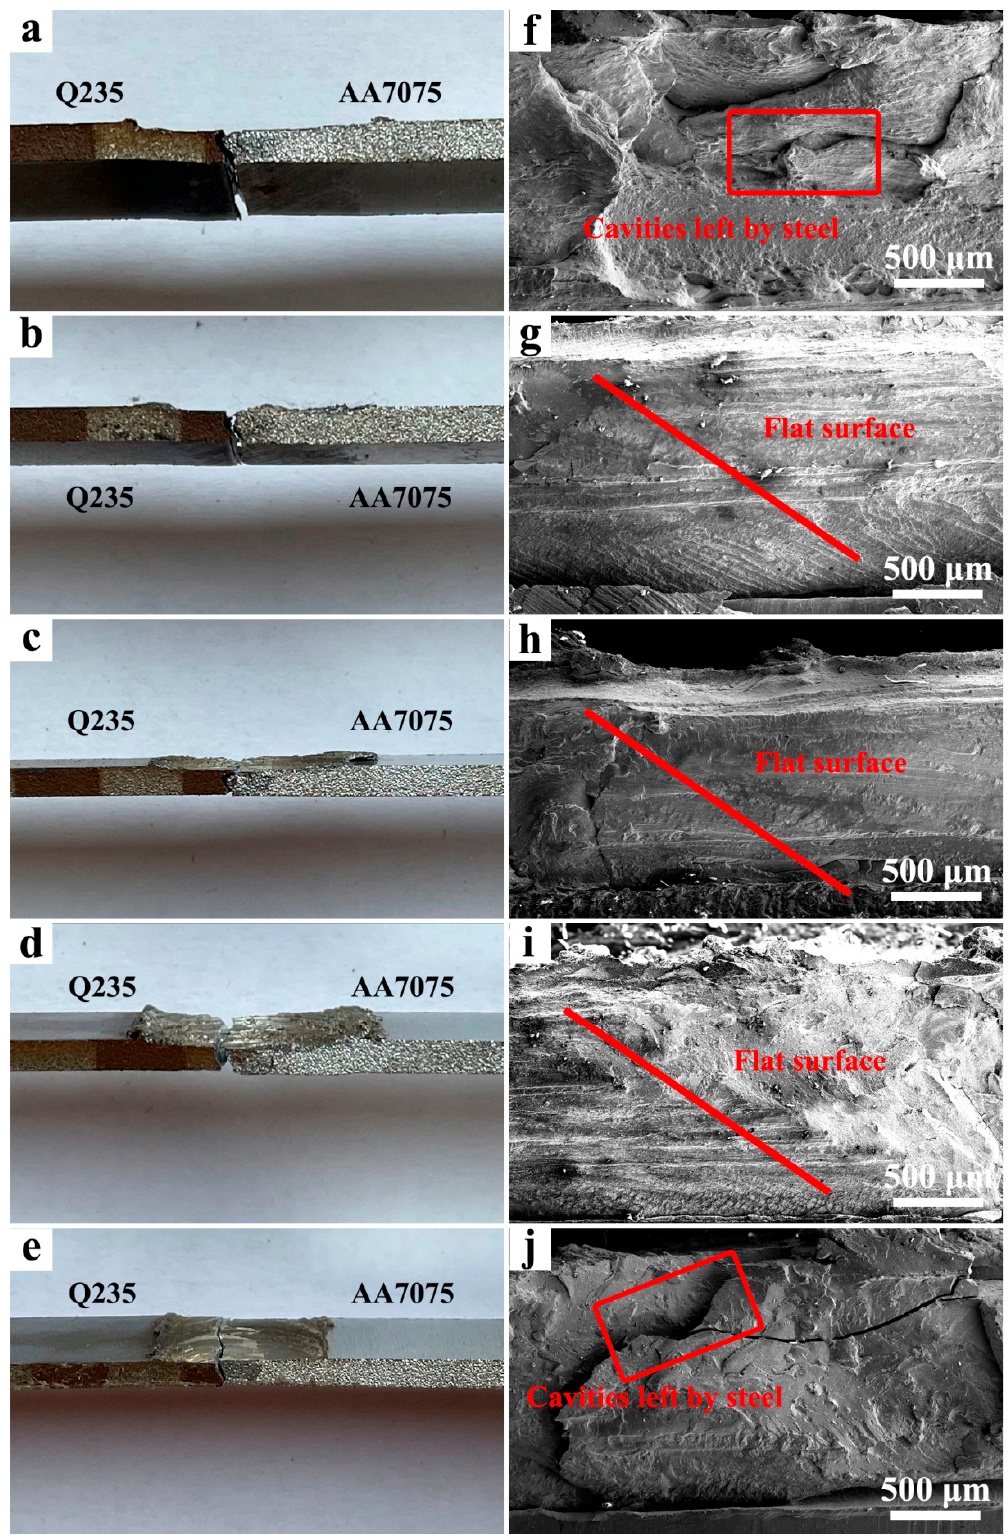
Figure 10. The fracture surfaces of the ( a , f ) 450/30, ( b , g ) 550/30 ( c , h ) 650/30, ( d , i ) 550/15, and ( e , j ) 550/60 samples.